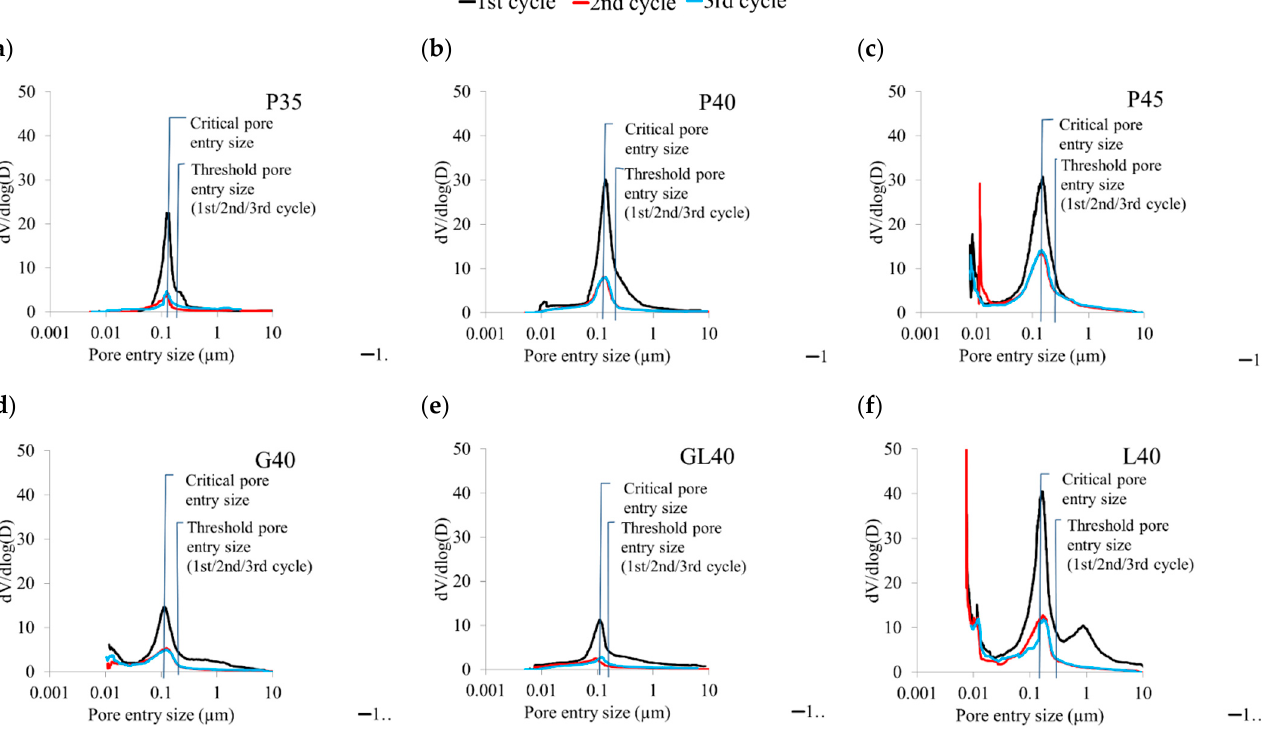
Figure 3. Derivative curves for multicycle MIP for mixes ( a ) P35, ( b ) P40, ( c ) P45, ( d ) G40, ( e ) GL40 and ( f ) L40.